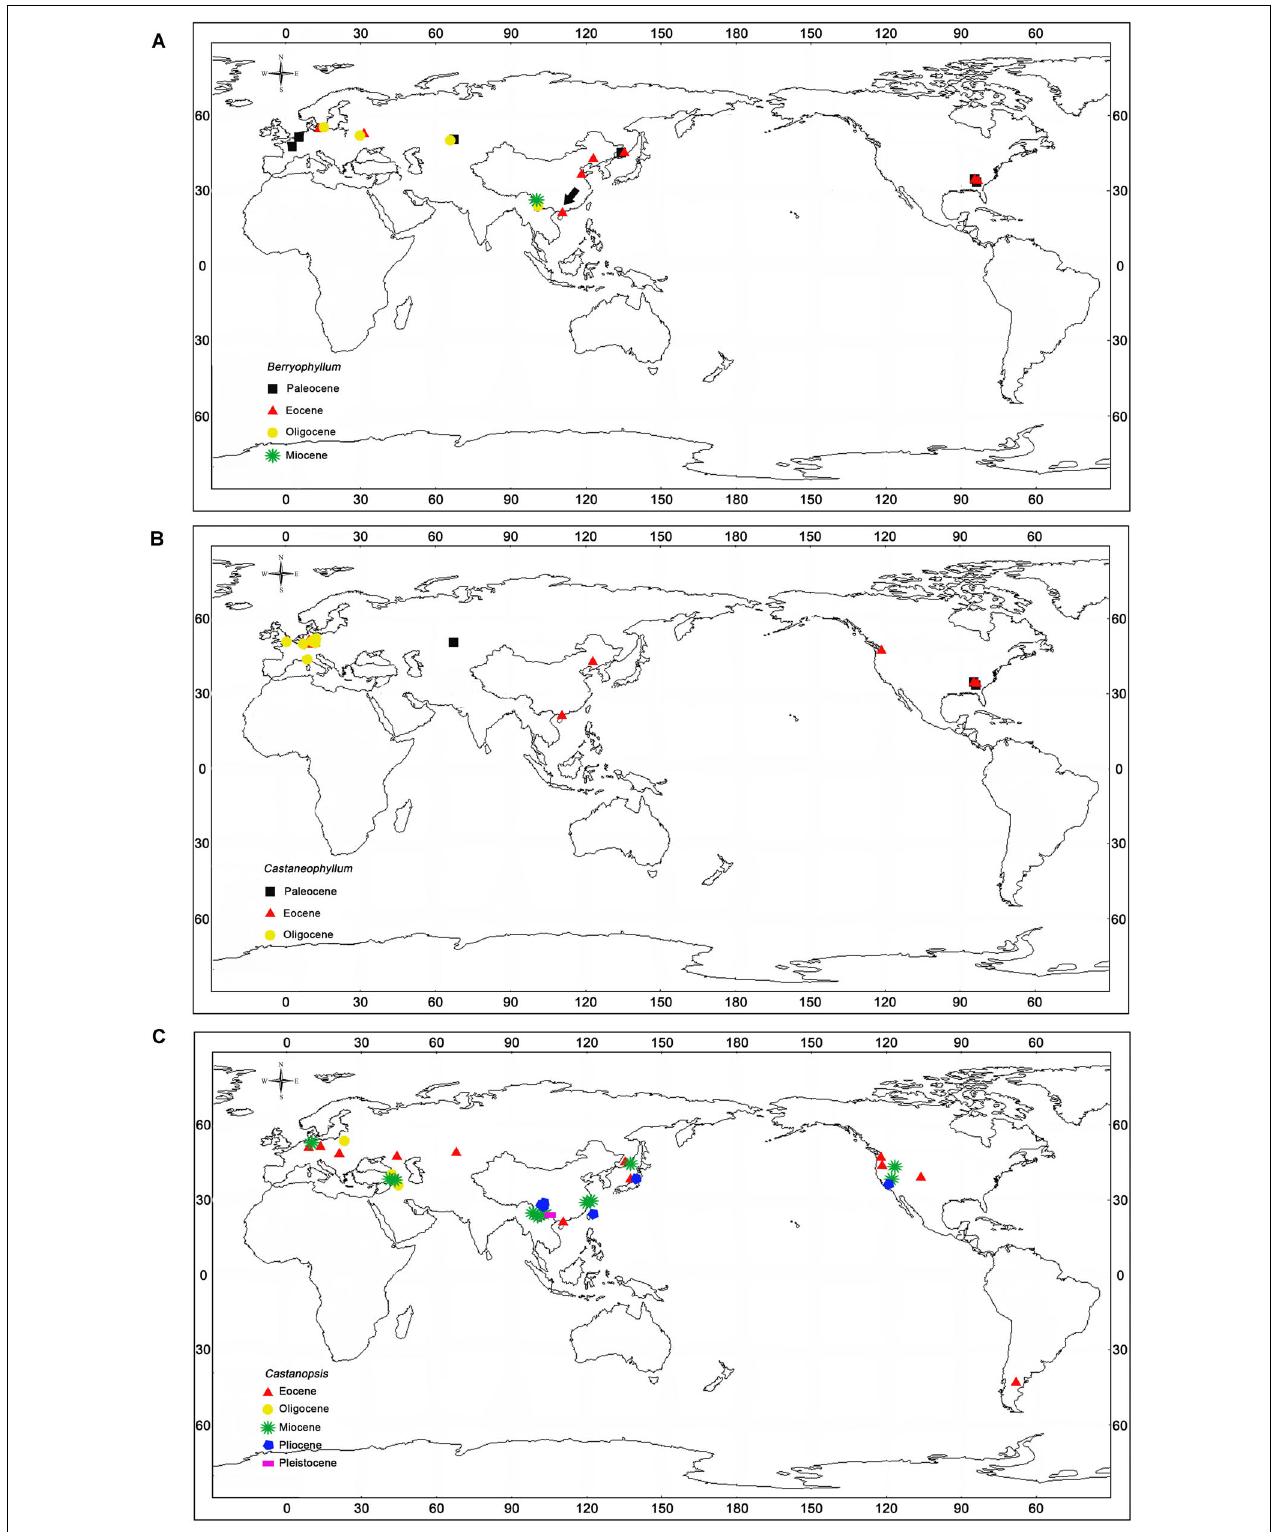
FIGURE 14 | Distribution of the fossil records for the genera Berryophyllum , Castaneophyllum and Castanopsis . (A) Distribution of the fossil records of Berryophyllum ; (B) distribution of the fossil records of Castaneophyllum ; (C) distribution of the fossil records of Castanopsis.